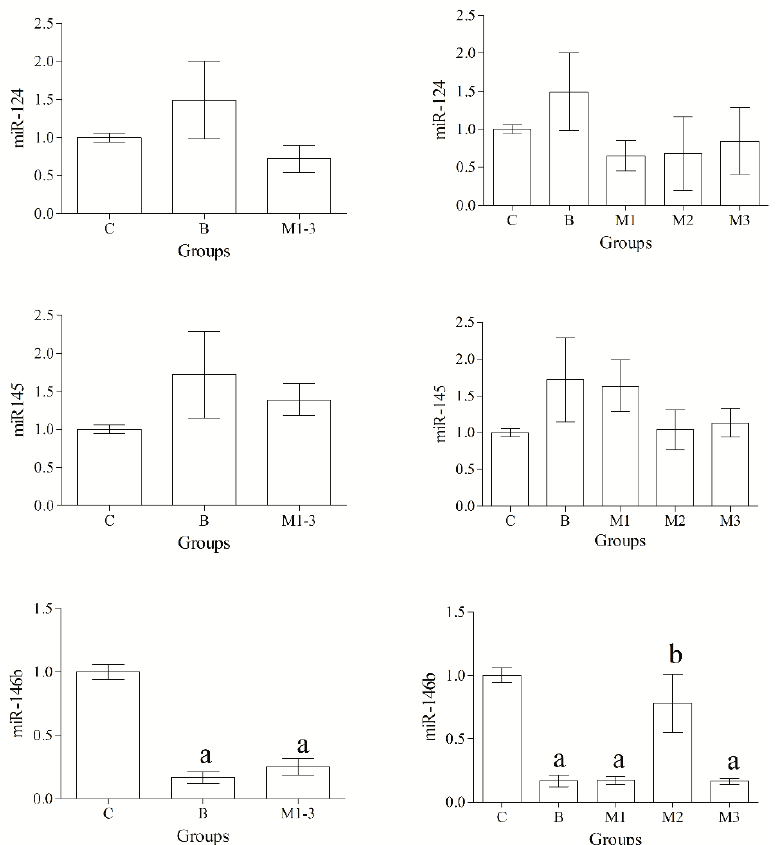
Figure 2. Expression levels of miR-124, miR-145, miR-146b. MiR-146b expression was significantly downregulated in benign (B) and malignant (M1-3) tumors compared with control mammary gland (C). Significant upregulation for miR-146b expression was observed in malignant tumors grade II (M2) compared with grade I (M1) and III (M3) and benign tumors (B). Significances ( p < 0.05): a vs. Group C; b vs. Group B, M1 and M3. Table 2. Pathway Enrichment for all statistically significant expressed